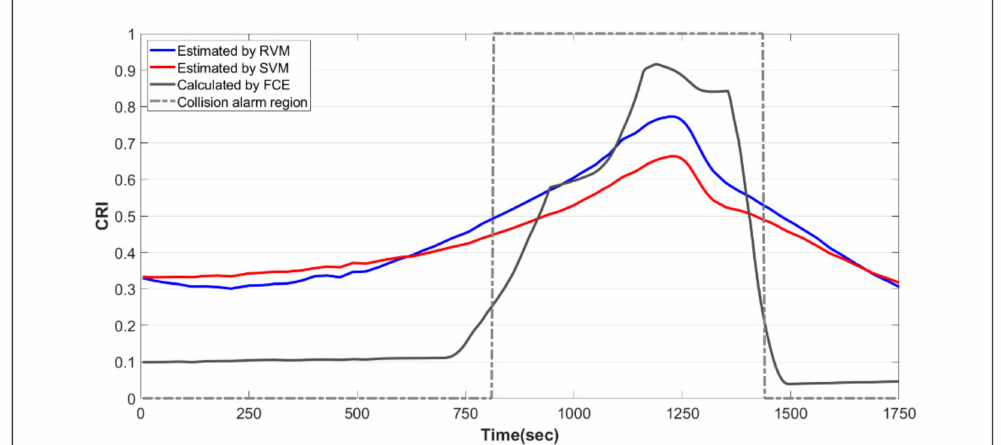
Figure 5. Results of estimation in the case of crossing